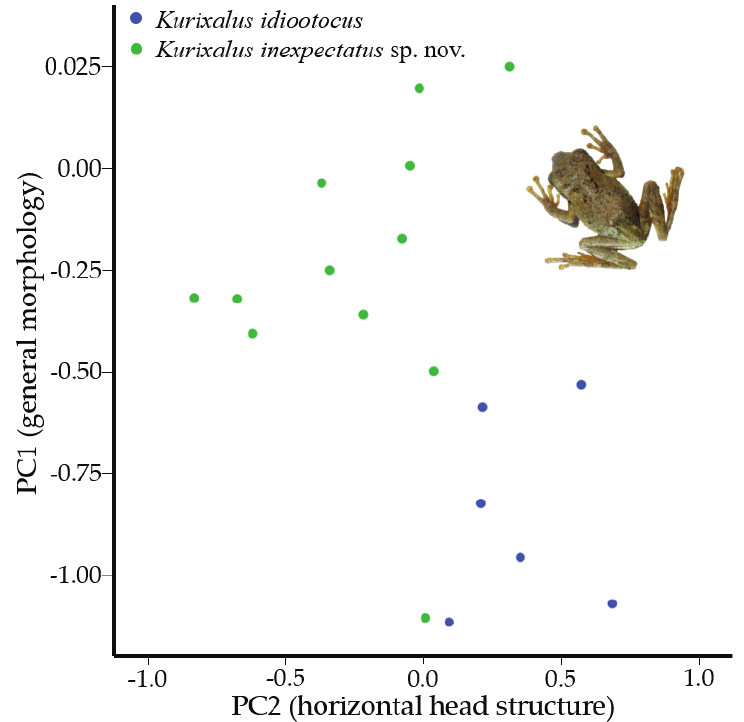
Figure 8. Plot of PC1 and PC2 resulting from the PCA and showing the non-clustering of morphologi- cal features between Kurixalus inexpectatus sp. nov. and Kurixalus idiootocus